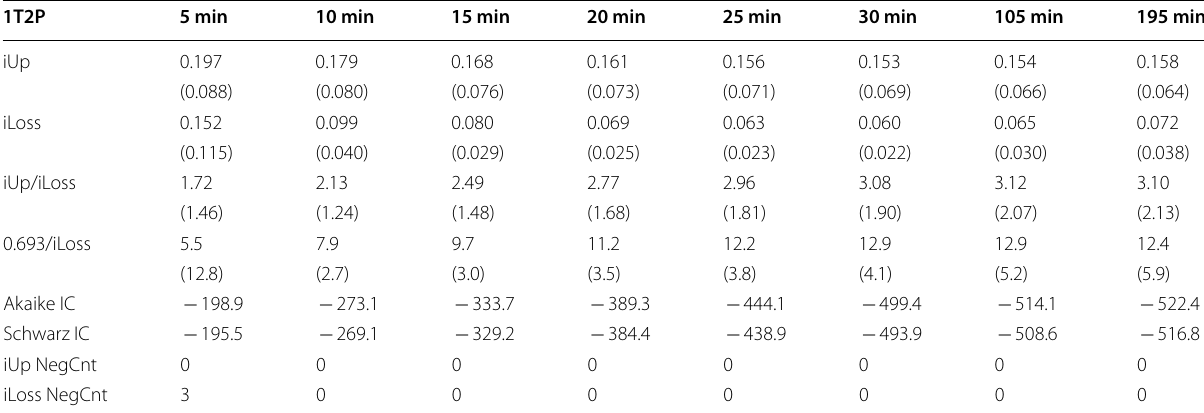
Means (and SDs) of kinetic indices of 1T2P, Akaike’s information criterion and Schwarz’s information criterion. NegCnt: negative counts that were unfavourable; 0.693/ iLoss is the pharmacological half life